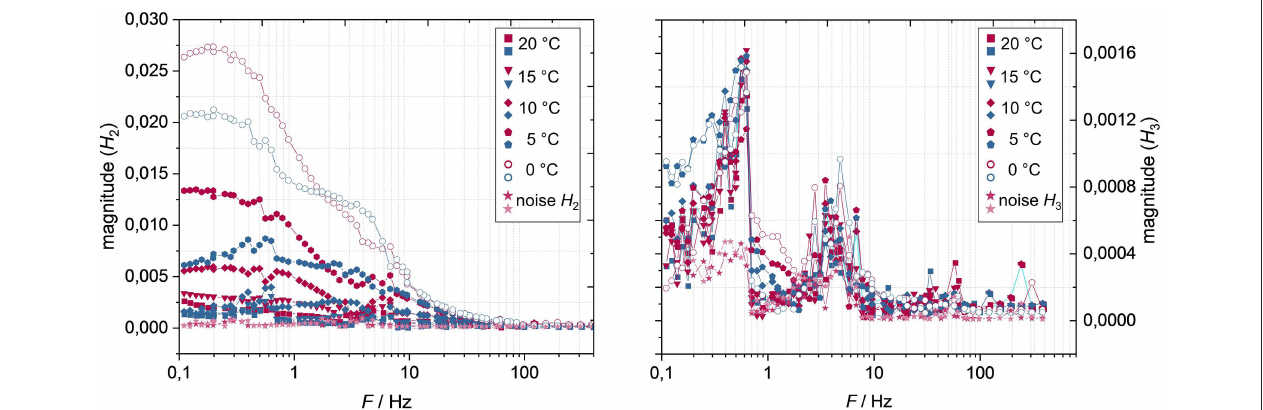
FIGURE 11 | NLEIS cell spectra of the 2nd harmonic (Left) and 3rd harmonic (Right) for charge (red) and discharge (blue) direction with the corresponding noises as a function temperature of and at a cell voltage of 3.7V.